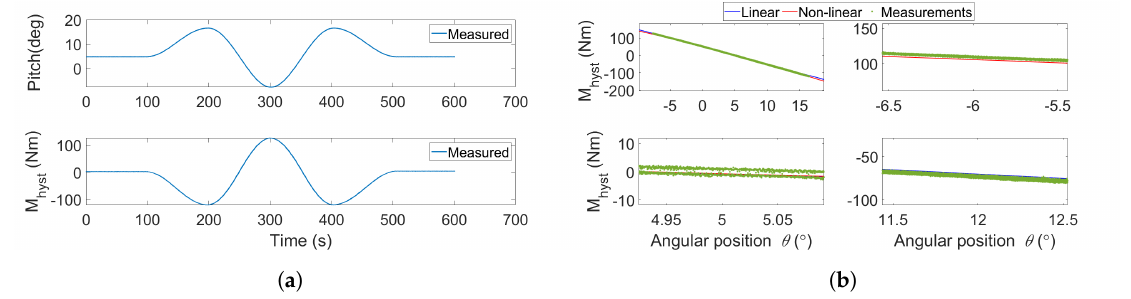
Figure 17. Data and results from hydrostatic tests. ( a ) Measured motion of the WEC (Pitch) and hydro-static moment ( M hyst ) from the slow-motion tests. ( b ) Calculated hydrostatic moment using non-linear and linear formulation compared to measured values. The different plots correspond to different intervals of angular position.